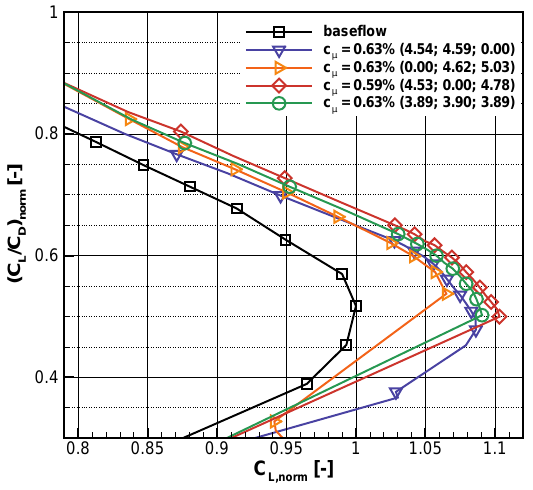
Figure 13. Aerodynamic efficiency vs. lift coefficient for forcing with c µ ≈